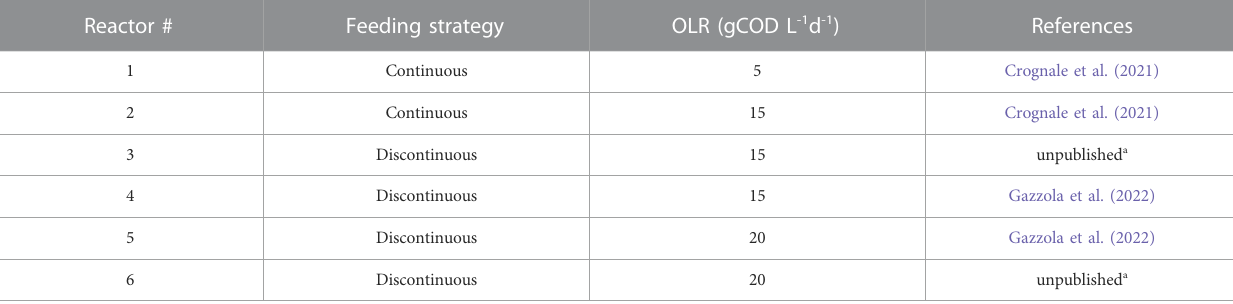
TABLE 1 Overview of the reactors considered in this work and the relative experimental conditions. Reactor